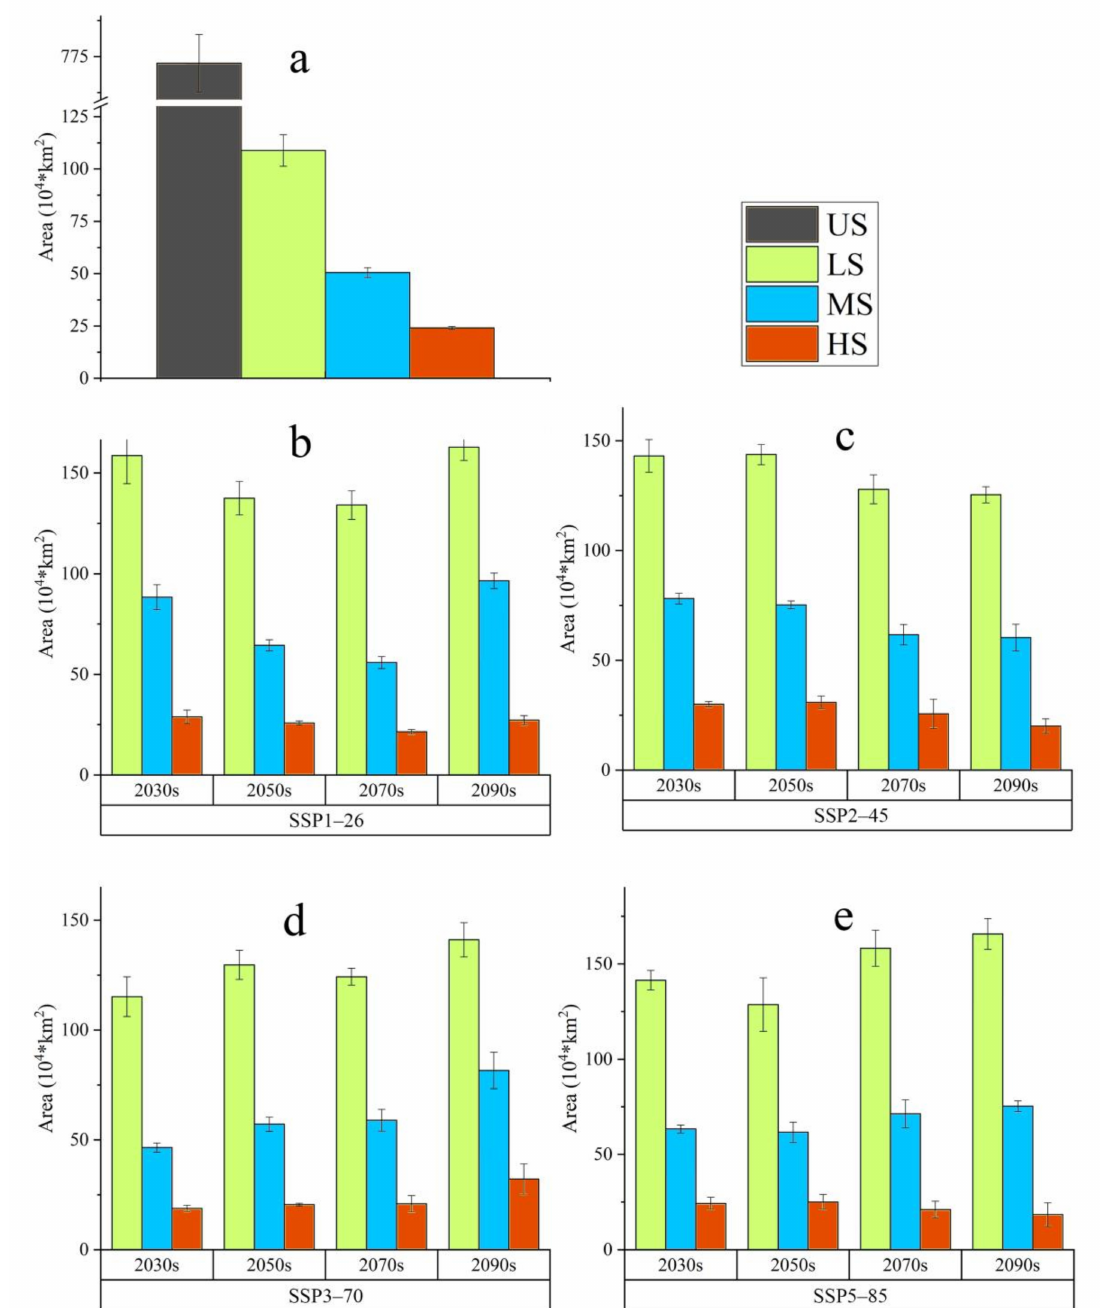
Figure 4. Suitable habitat area of the present ( e ) and future (2030s, 2050s, 2070s, and 2090s) under four climate scenarios: ( a ) SSP1–26, ( b ) SSP2–45, ( c ) SSP3–70, ( d ) SSP5–85. The US, LS, MS, and HS represent the suitability of unsuitable, low suitable, moderately suitable, and highly suitable, respectively. The error bars represent the standard deviation of